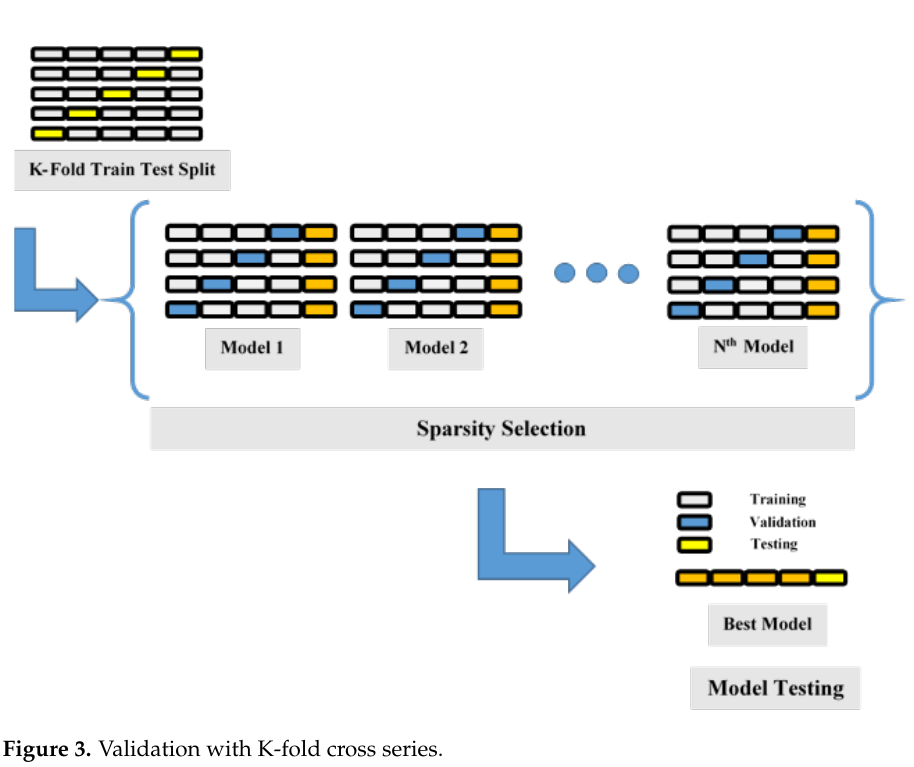
Figure 3. Validation with K-fold cross series.